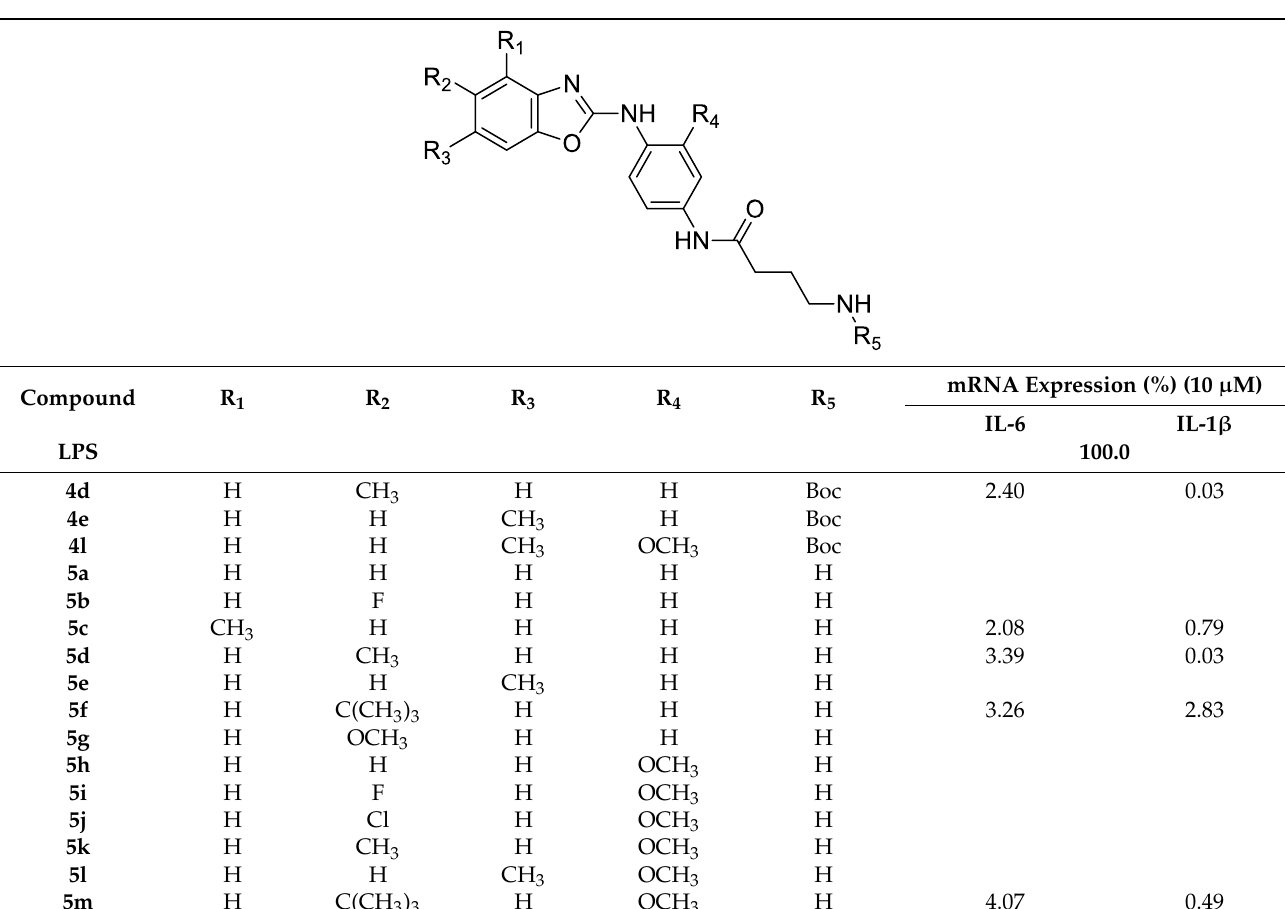
Table 1. Inhibitory effects of 4-amino- N -(4-(benzo[ d ]oxazol-2-ylamino)phenyl)butanamide deriva- tives on mRNA expression levels of IL-6 and IL-1 β .